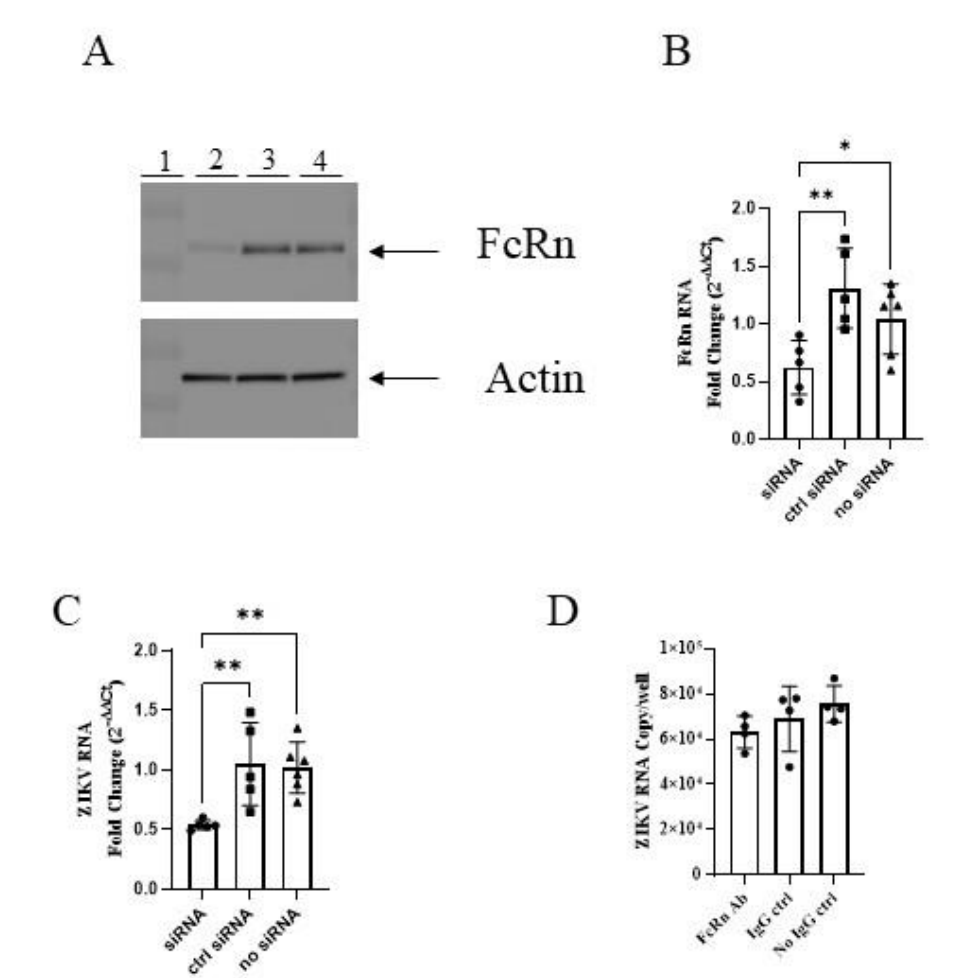
Figure 2. siRNA knockdown of FcRn in MDCK/FcRn cells reduces ZIKV infection. ( A ) Western blot demonstrating knock-down of FcRn receptor expression in MDCK/FcRn cells. Lane 1—molecular weight marker; 2—FcRn siRNA; 3—control siRNA; 4—no siRNA. ( B ) RT qPCR showing knock-down expression of FcRn at the mRNA level. ( C ) Less ZIKV mRNA is seen in cells with knock down expression of FcRn. One representative of two independent experiments is shown ( A – C ), with at least five biological repeats per each cell culture analyzed by PCR ( B , C ). ( D ) No statistical difference in ZIKV mRNA is seen in cells treated with anti-FcRn antibody before infection, although the levels are trending lower. One experiment with four biological repeats was performed. The data was analyzed with ordinary one-way ANOVA, * p < 0.05, ** p <